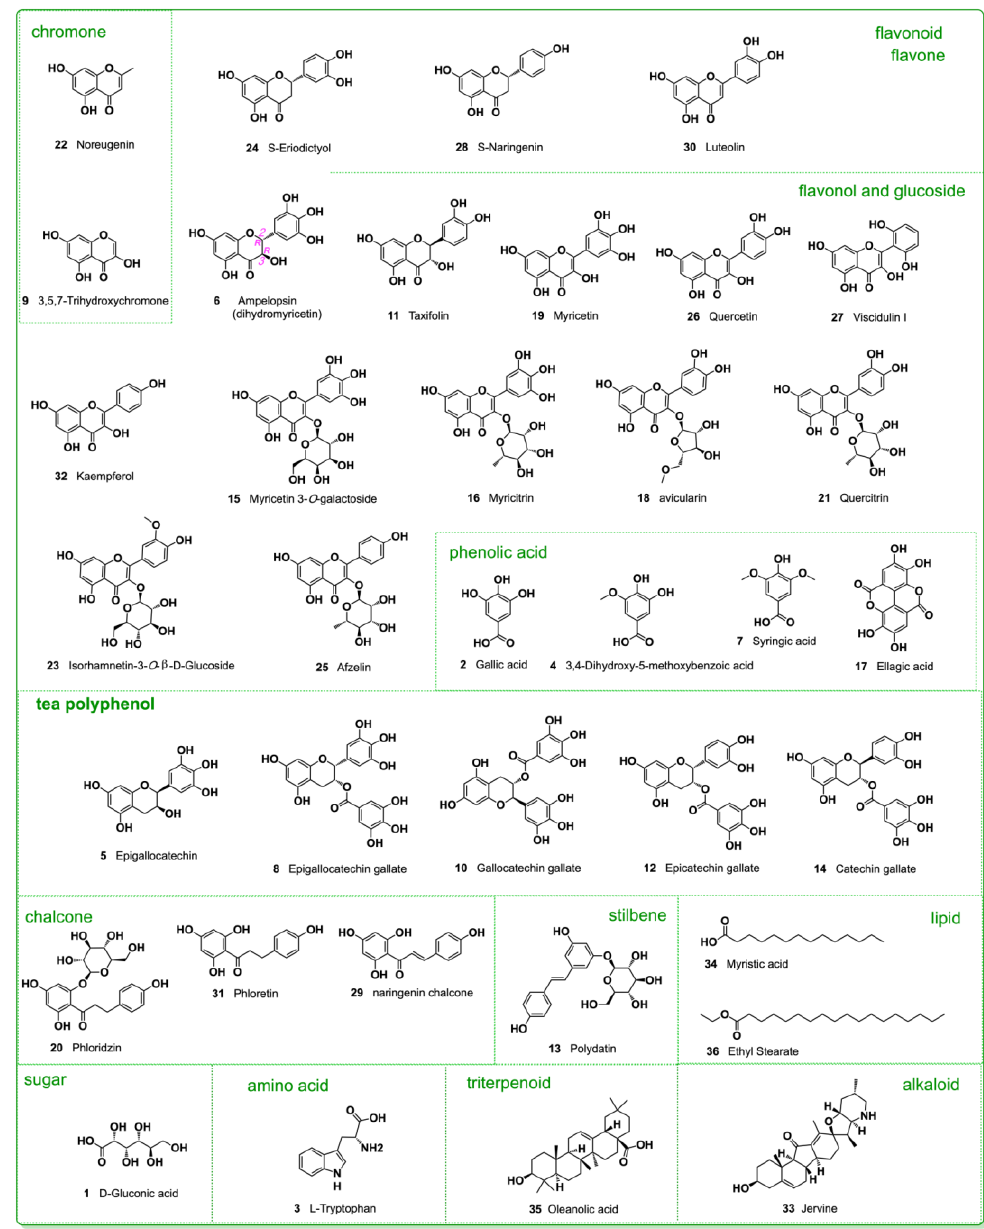
Figure 3. The names and structures of 36 putatively identified bioactive compounds in vine tea. The identification process was detailed in Supplementary Files. 1 – 36. Compound 35 was at trace level.